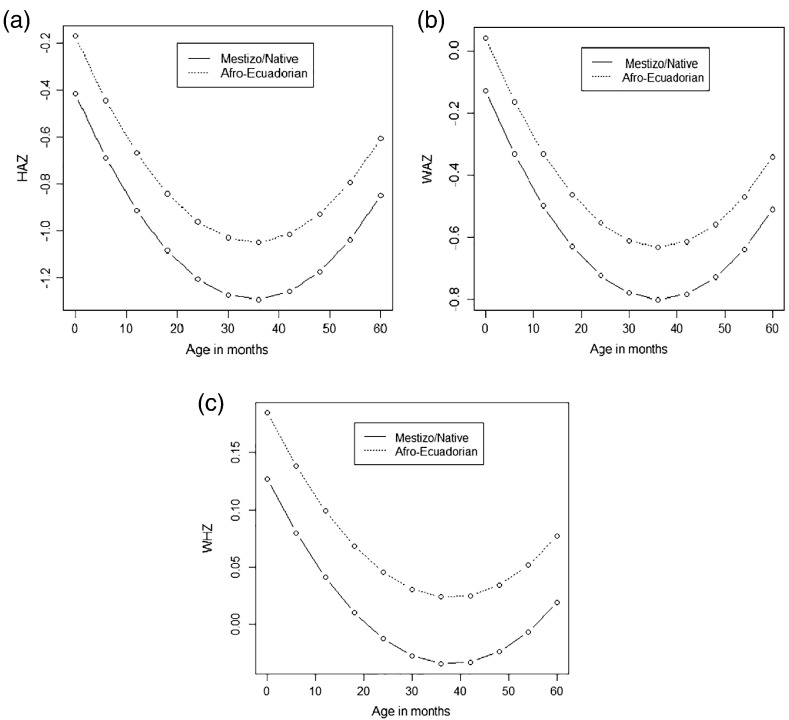
Growth trajectories* for (a) HAZ, (b) WAZ and (c) WHZ stratified by child's ethnicity**. Ecuador, 2005–2009.* Means ± SD estimated**Native = Indigenous or Amerindian children.